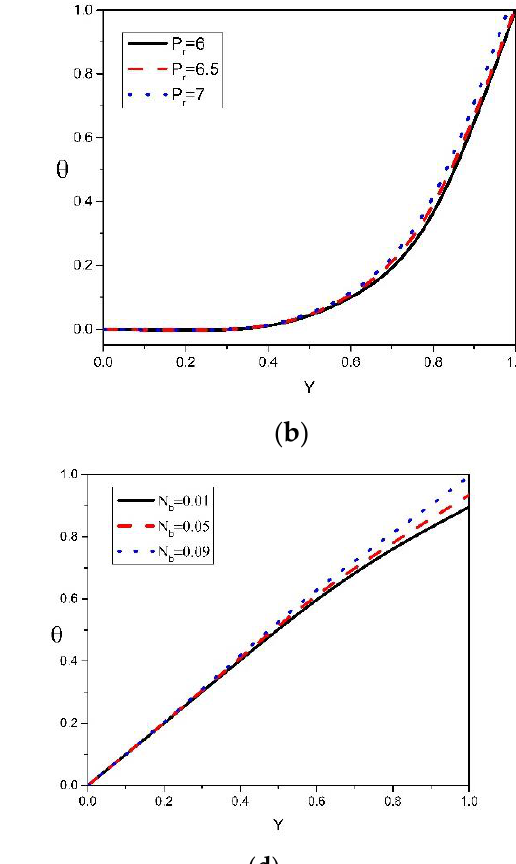
Figure 3. ( a – d ) Temperature distribution versus Y for various physical parameters ( a ) N = 0.7, N = 0.7, N = 0.5, N t = 0.5, P r = 7, ( b ) N CT TC b R d = 0.5. ( c ) N CT = 0.7, N TC = 0.7, R d = 0.5, N t = 0.5, P r = 7, ( d ) N CT = 0.7, N TC = 0.7, N b = 0.5, R d = 0.5, P r =